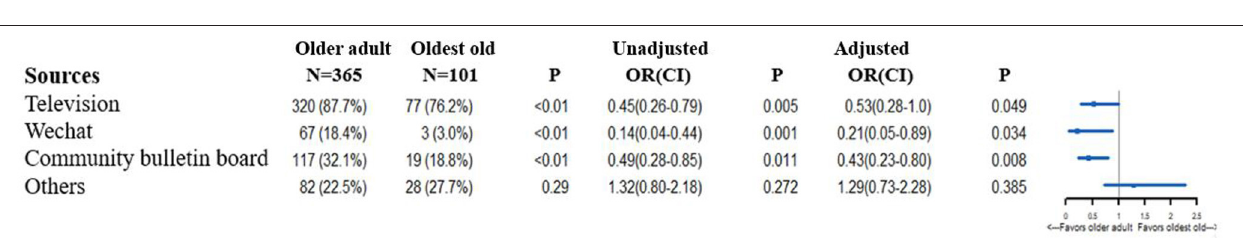
FIGURE 3 | Differences in the sources of acquiring stroke-related knowledge between older adults and the oldest old. OR, Odds Ratio; CI, Confidence Interval. In the multivariable logistic regression analysis, we adjusted gender, educational background, smoking history, drinking habit, hypertension, diabetes, myocardial infarction, prior stroke, dyslipidemia, cancer history, atrial fibrillation. The OR means the comparison between the older adults and oldest old (oldest old vs. the older